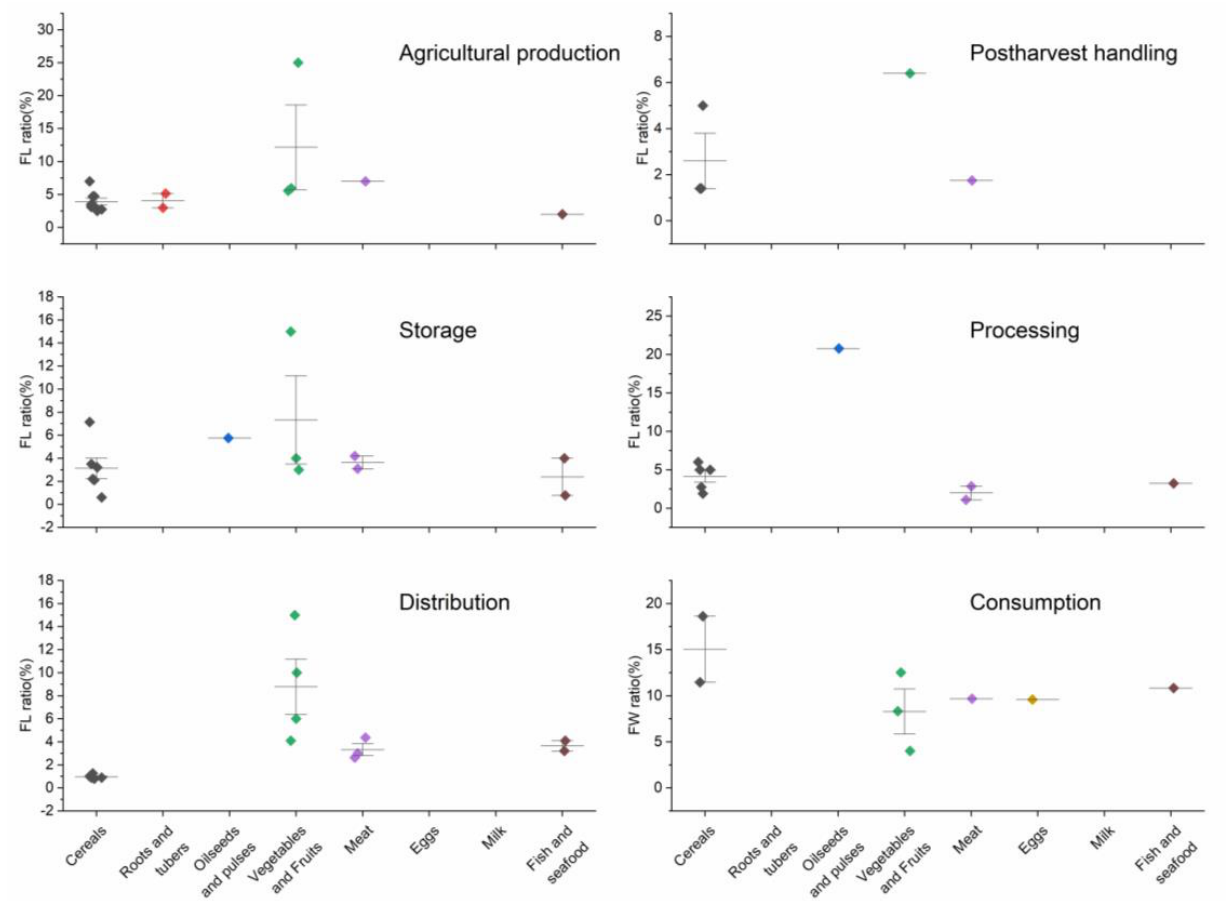
Figure 2. Distribution of literature found for the FLW ratio along the FSC.